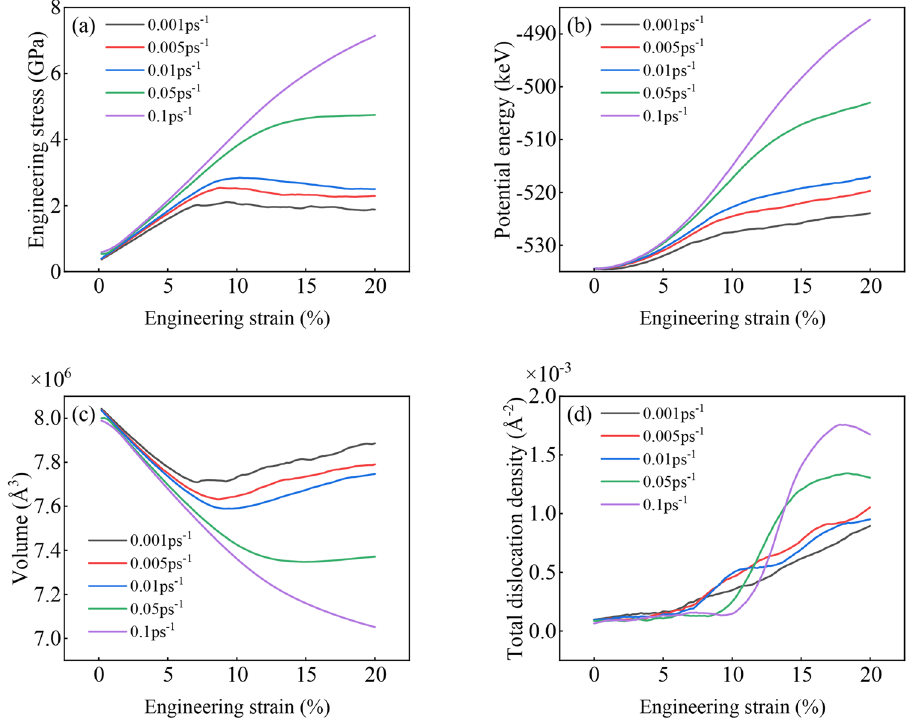
Figure 18: Force energy parameter curve: ( a ) stress – strain curve, ( b ) potential energy curve, ( c ) volume curve, and ( d ) total dislocation density curve.